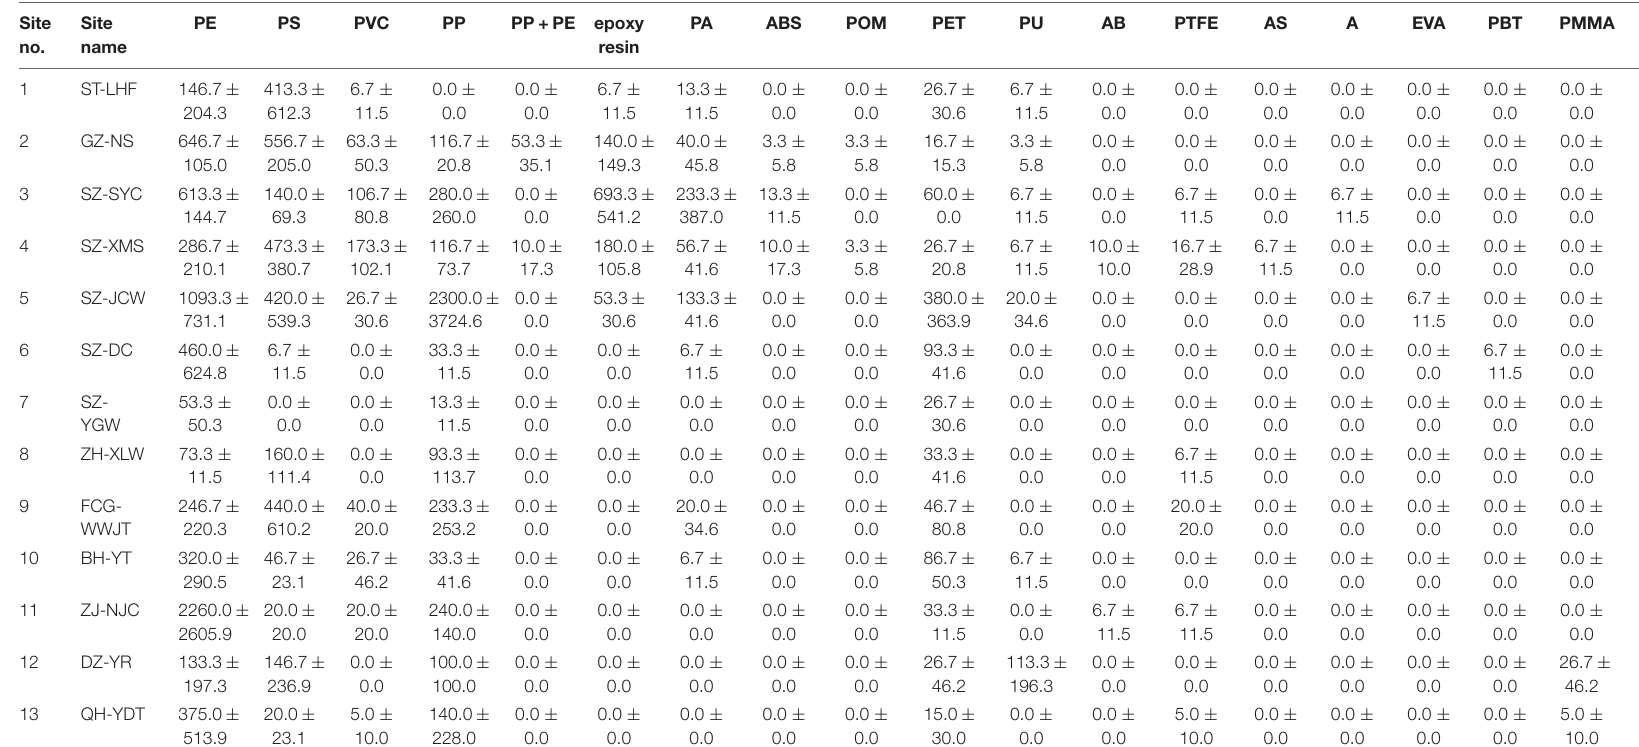
TABLE 2 | Types and abundance of MPs (n kg − 1 ) in the surface sand (0–5 cm) collected from the beach along the coasts of South China. Site